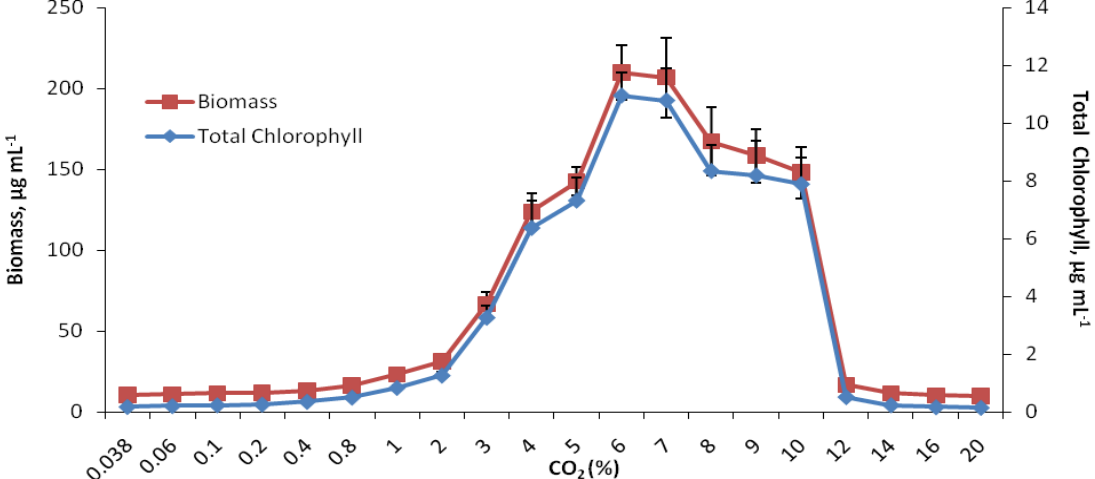
Figure 1. Growth response of Chlorella vulgaris ARC 1 at graded CO Data points represent mean values of triplicates and error bars are standard deviations. C.D. at 5% for chlorophyll and biomass is 0.343 and 7.860,